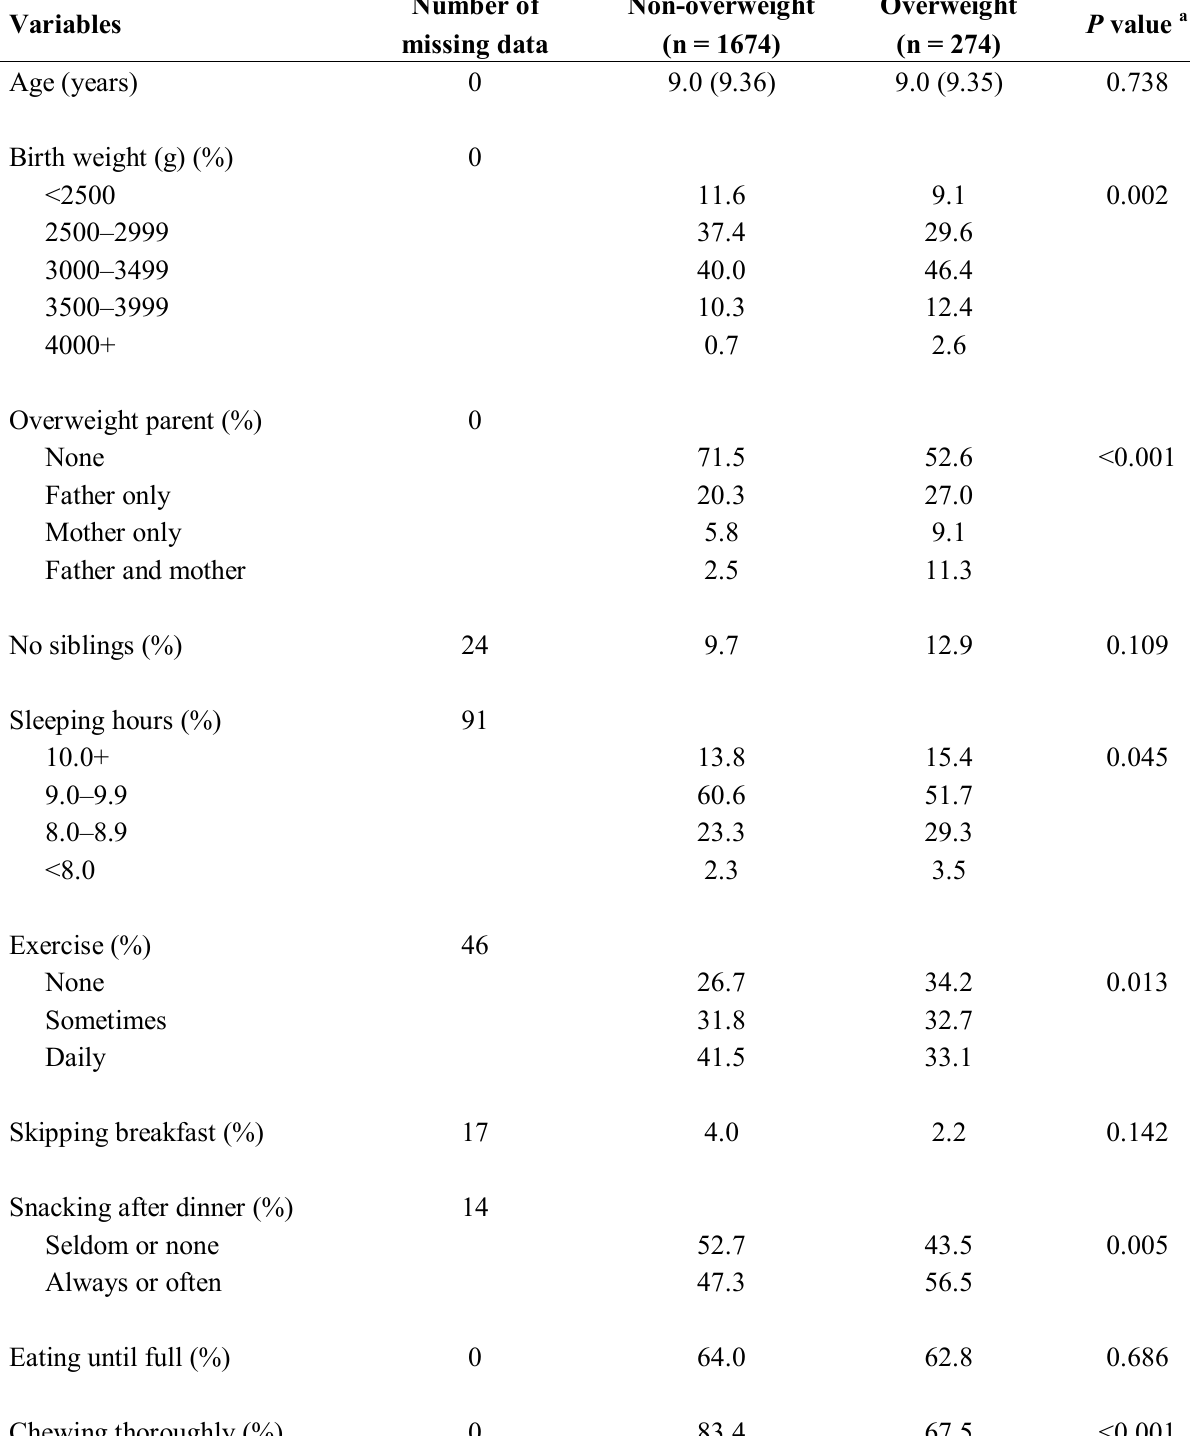
Table 2. Characteristics of non-overweight and overweight participants